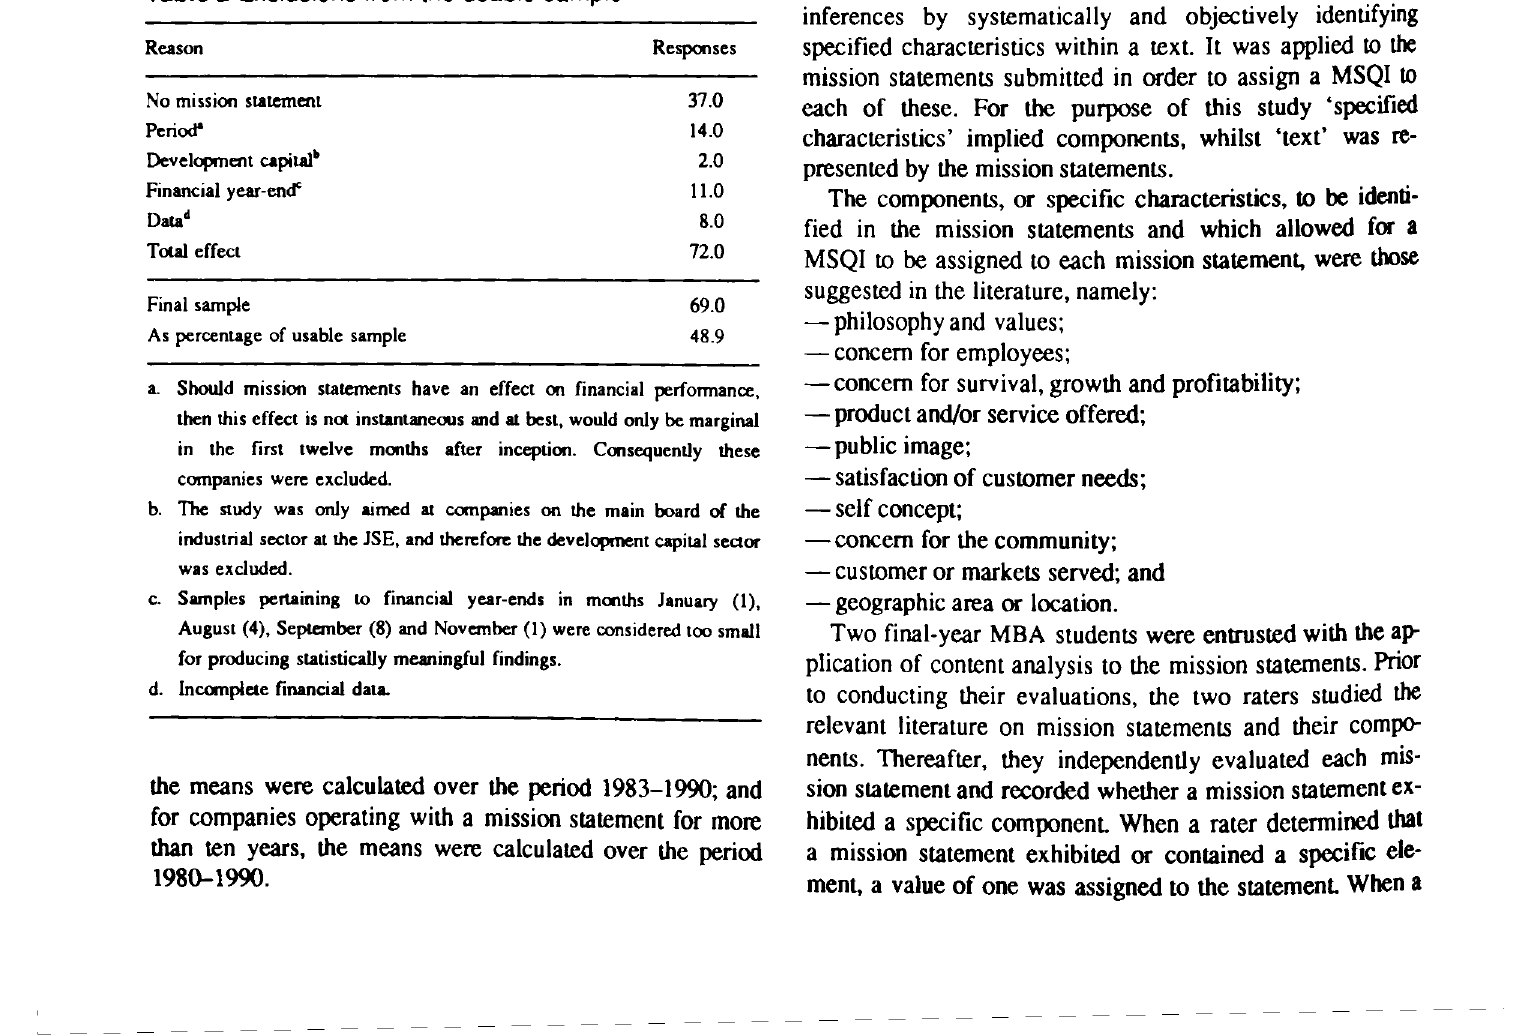
Table 2 Exclusions from the usable sample